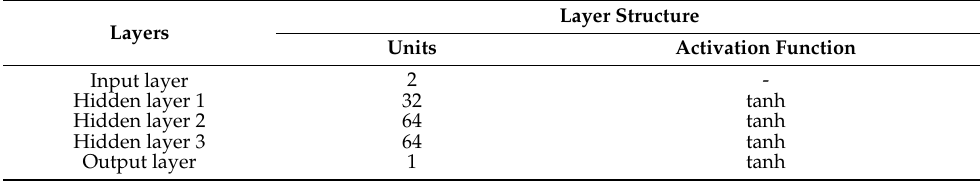
Table 8. The structure of actor network µ ( s ; θ µ )